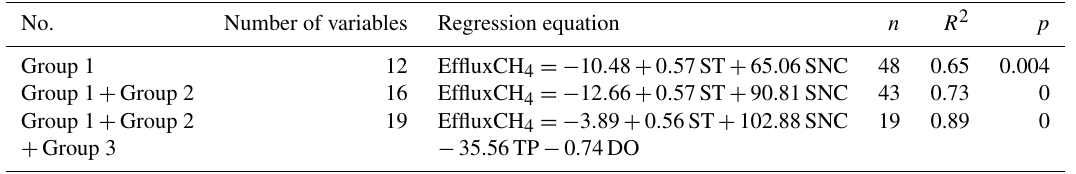
Table 3. Multivariate regressions between seasonal CH 4 efflux and environment factors No. Number of variables Regression equation